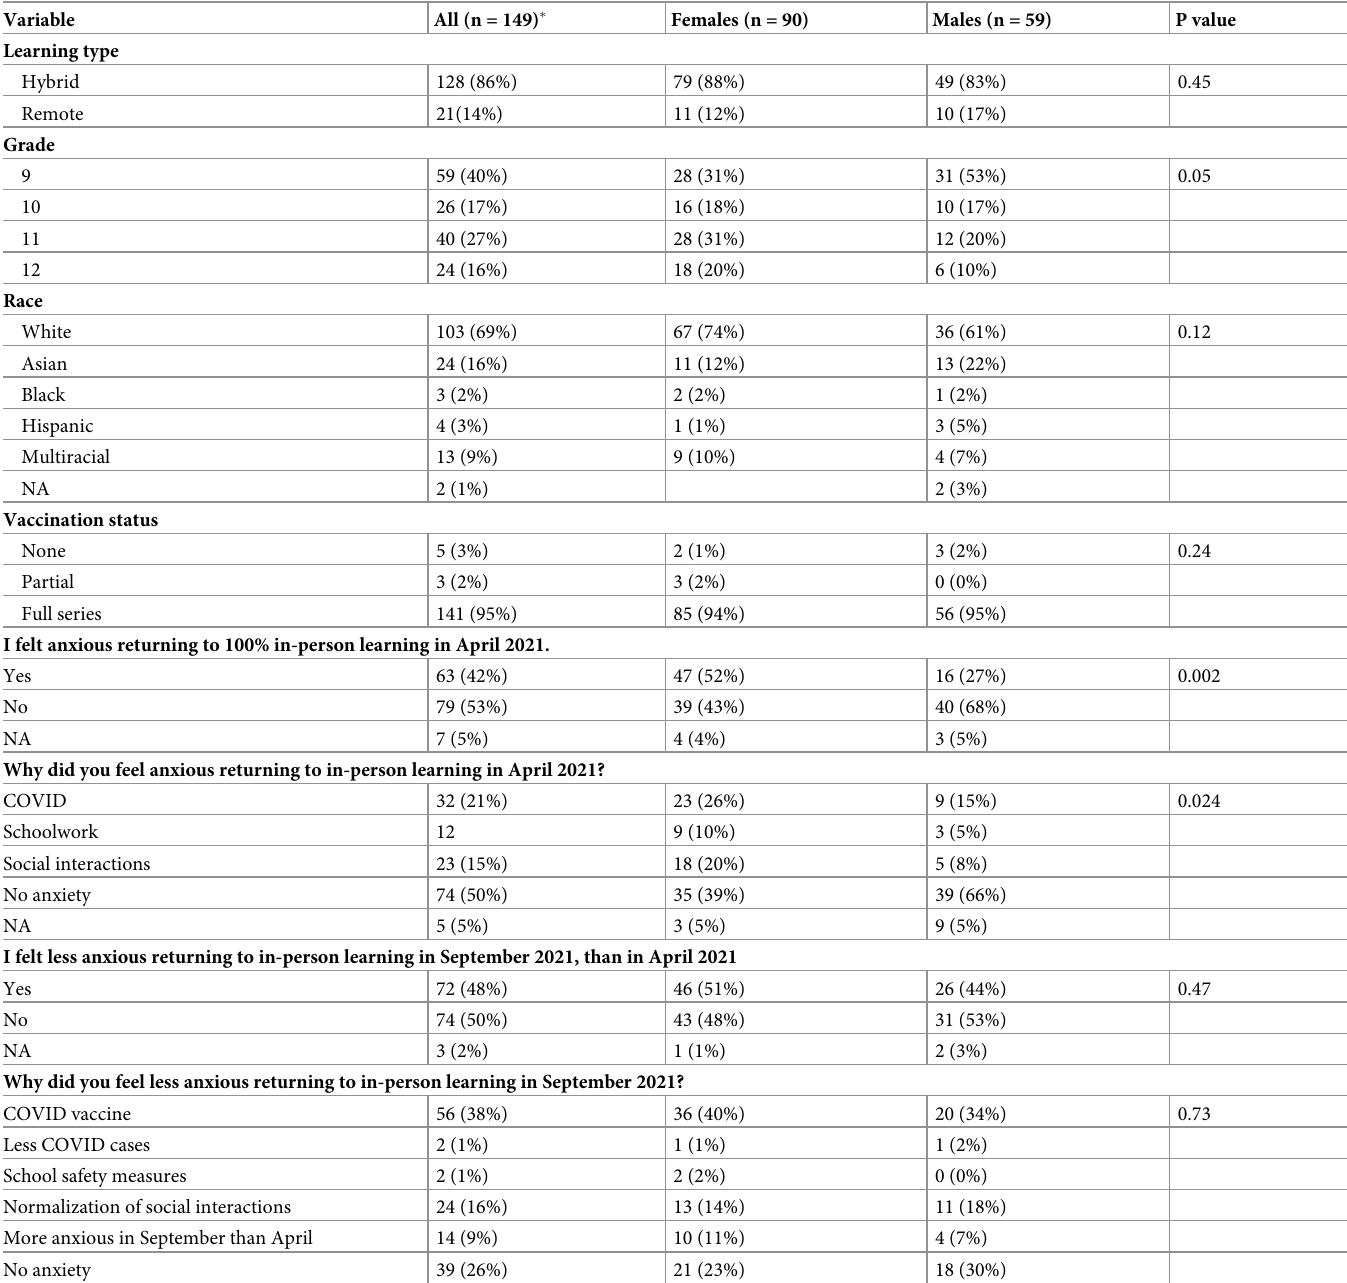
Table 1. Demographics, vaccination status, and anxiety related to in-person learning, stratified by gender.